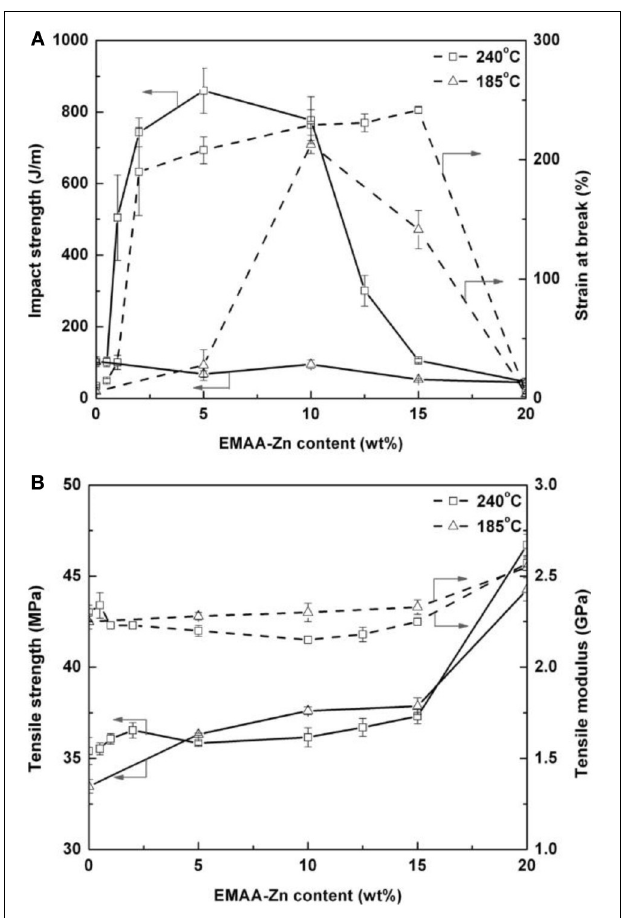
FIGURE 21 | Mechanical properties of PLA/EBA-GMA/EMAA-Zn (80/x/y in weight, x + y = 20) blends as functions of weight content of added EMAA-Zn under 240 ◦ C vs. 185 ◦ C: (A) impact strength (solid line) and strain at break (%) (dashed line); (B) tensile strength (solid line) and tensile modulus (dashed line). Liu et al. (2010).